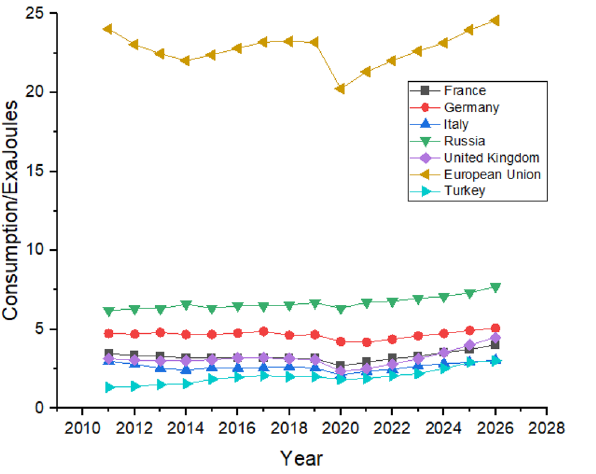
Figure 7. Oil Consumption in European